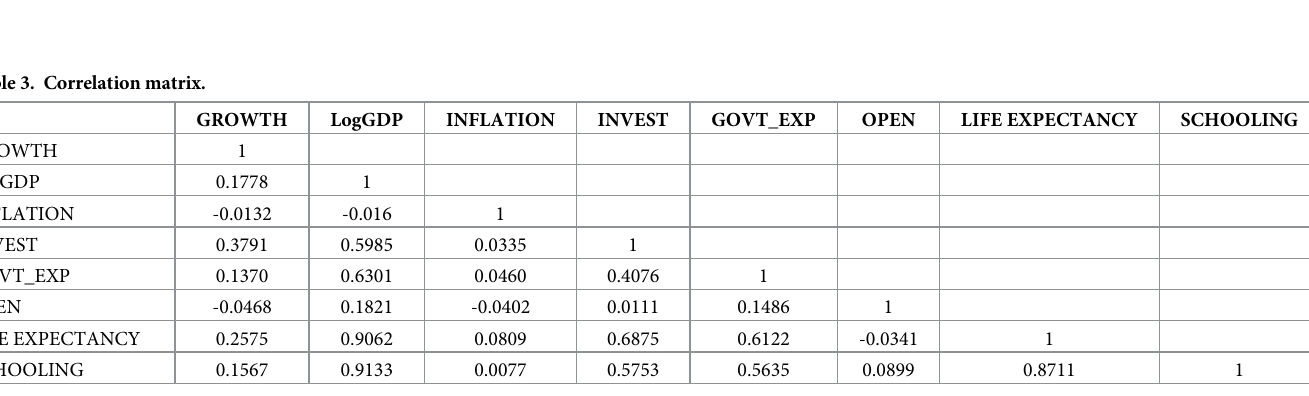
Table 3. Correlation